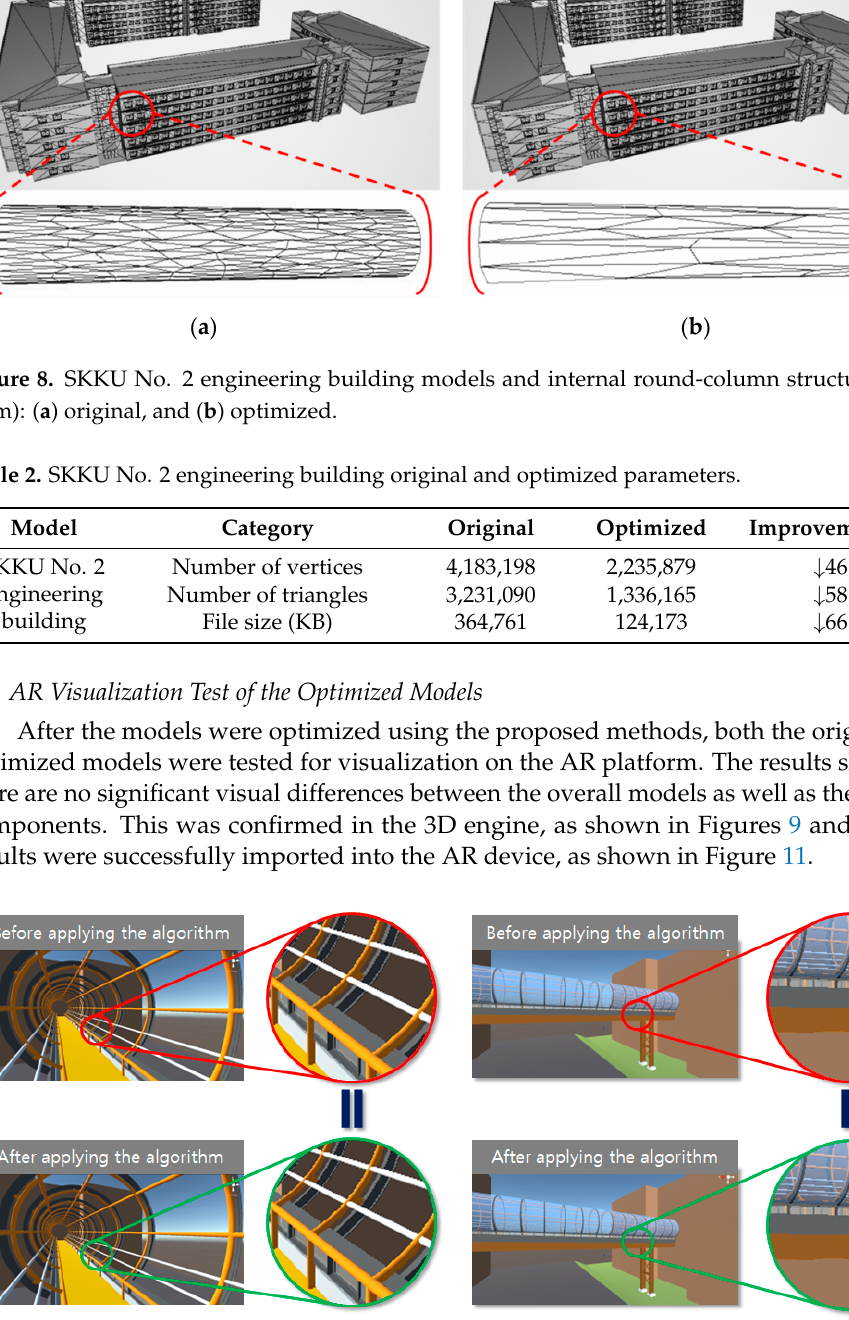
Figure 9. SKKU steel bridge in 3D engine before and after applying algorithm.